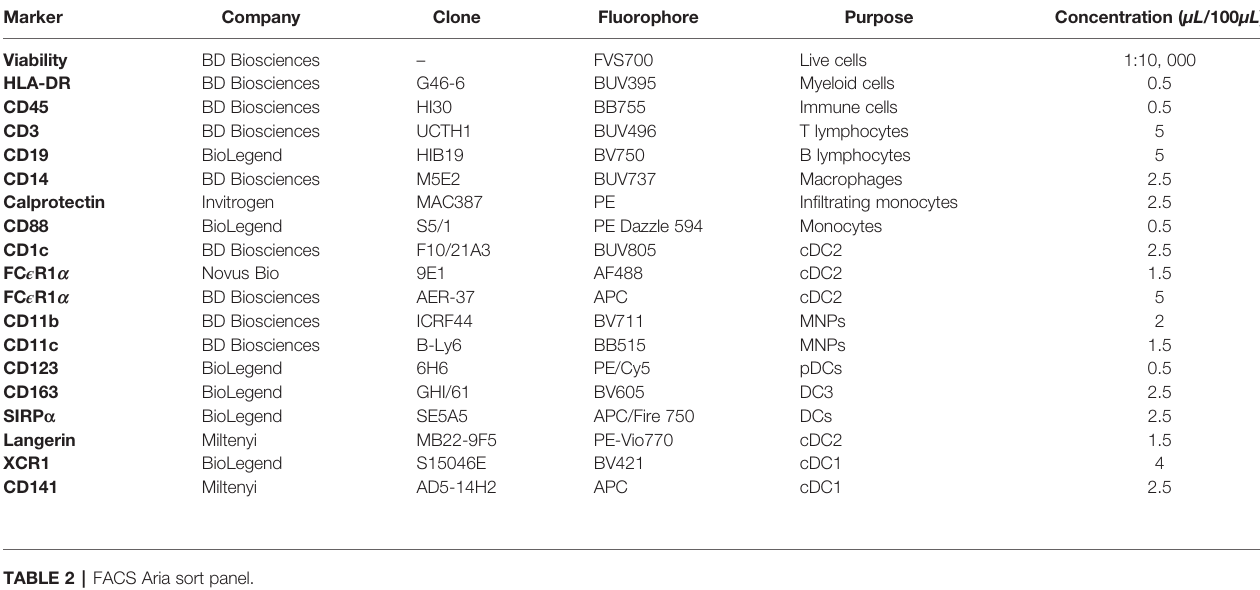
TABLE 1 | FACSymphony mononuclear phagocyte phenotyping panel. Marker